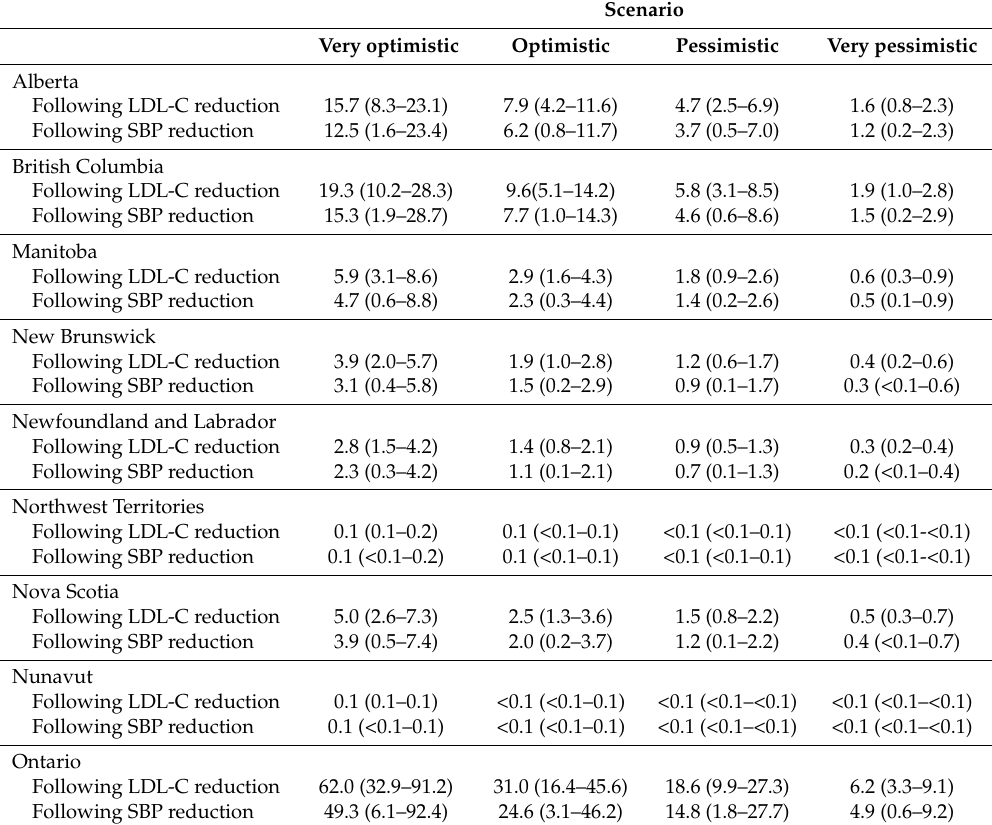
Table 8. Sum of potential annual savings in healthcare and related costs of cardiovascular disease among Canadian adults from 100 g/day dietary pulse intake by province and territory (Can$ million).